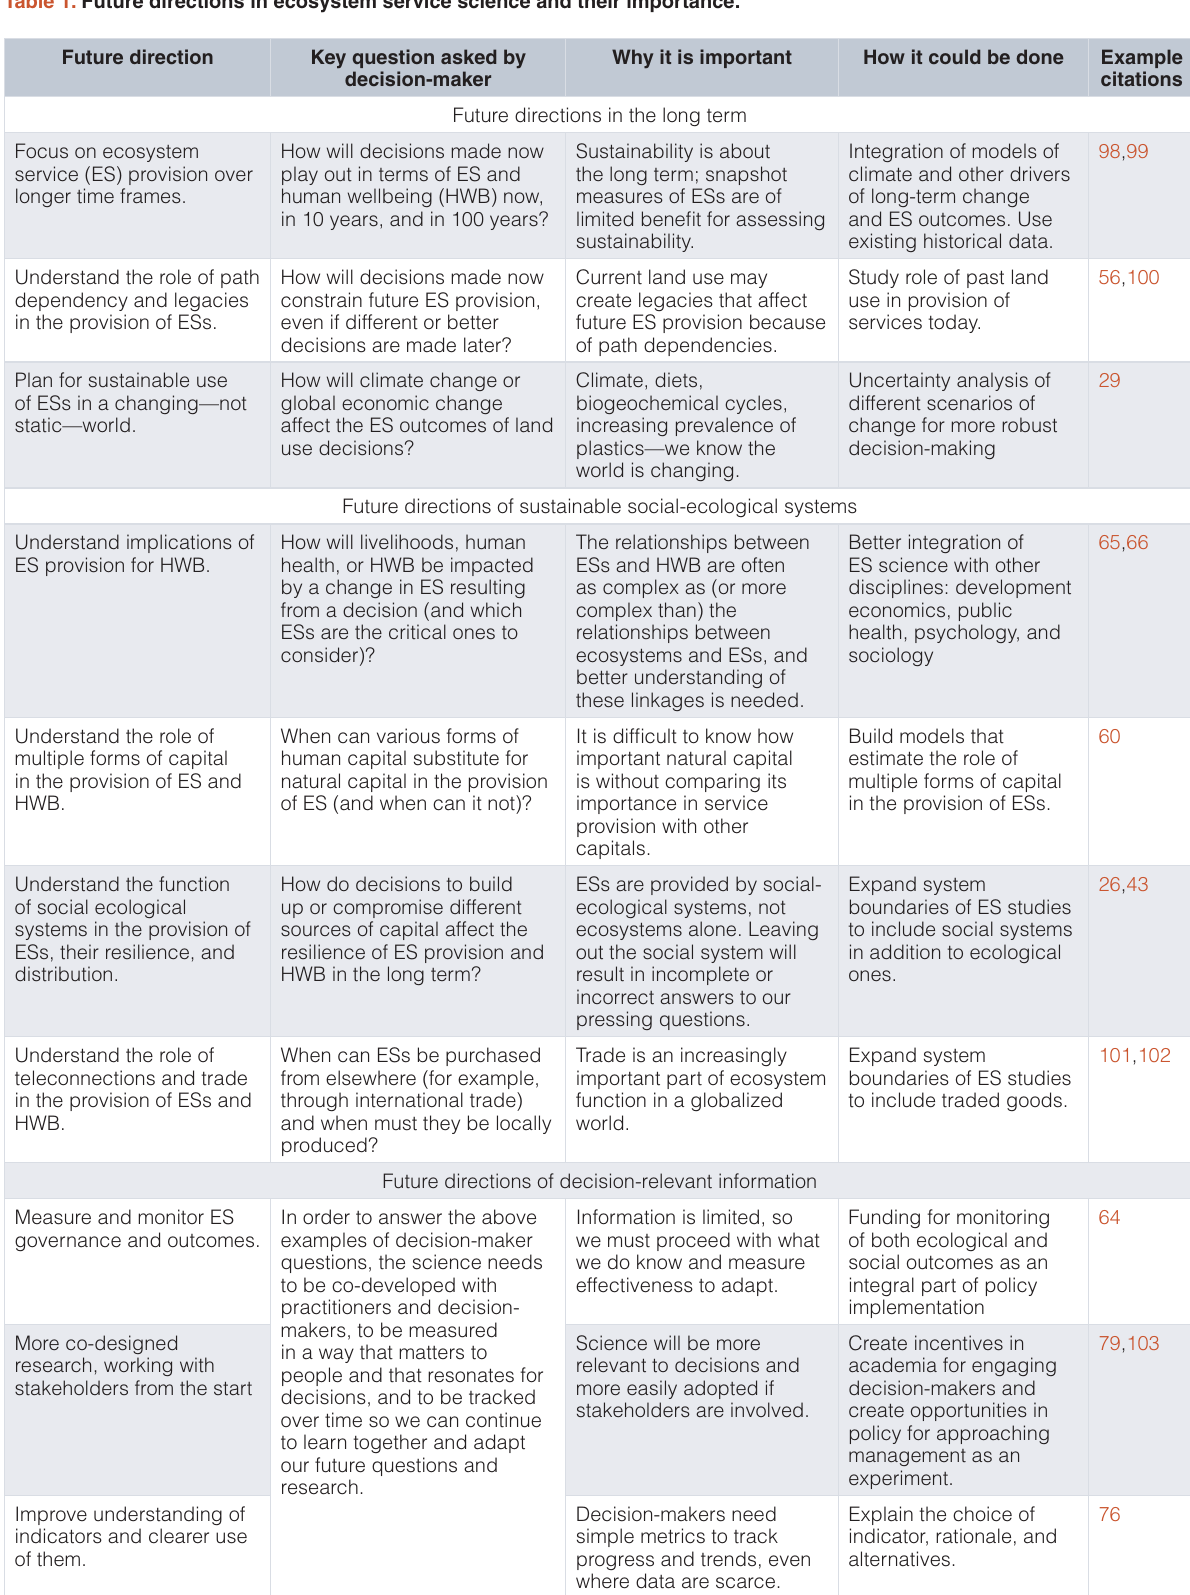
Table 1. Future directions in ecosystem service science and their importance. Future